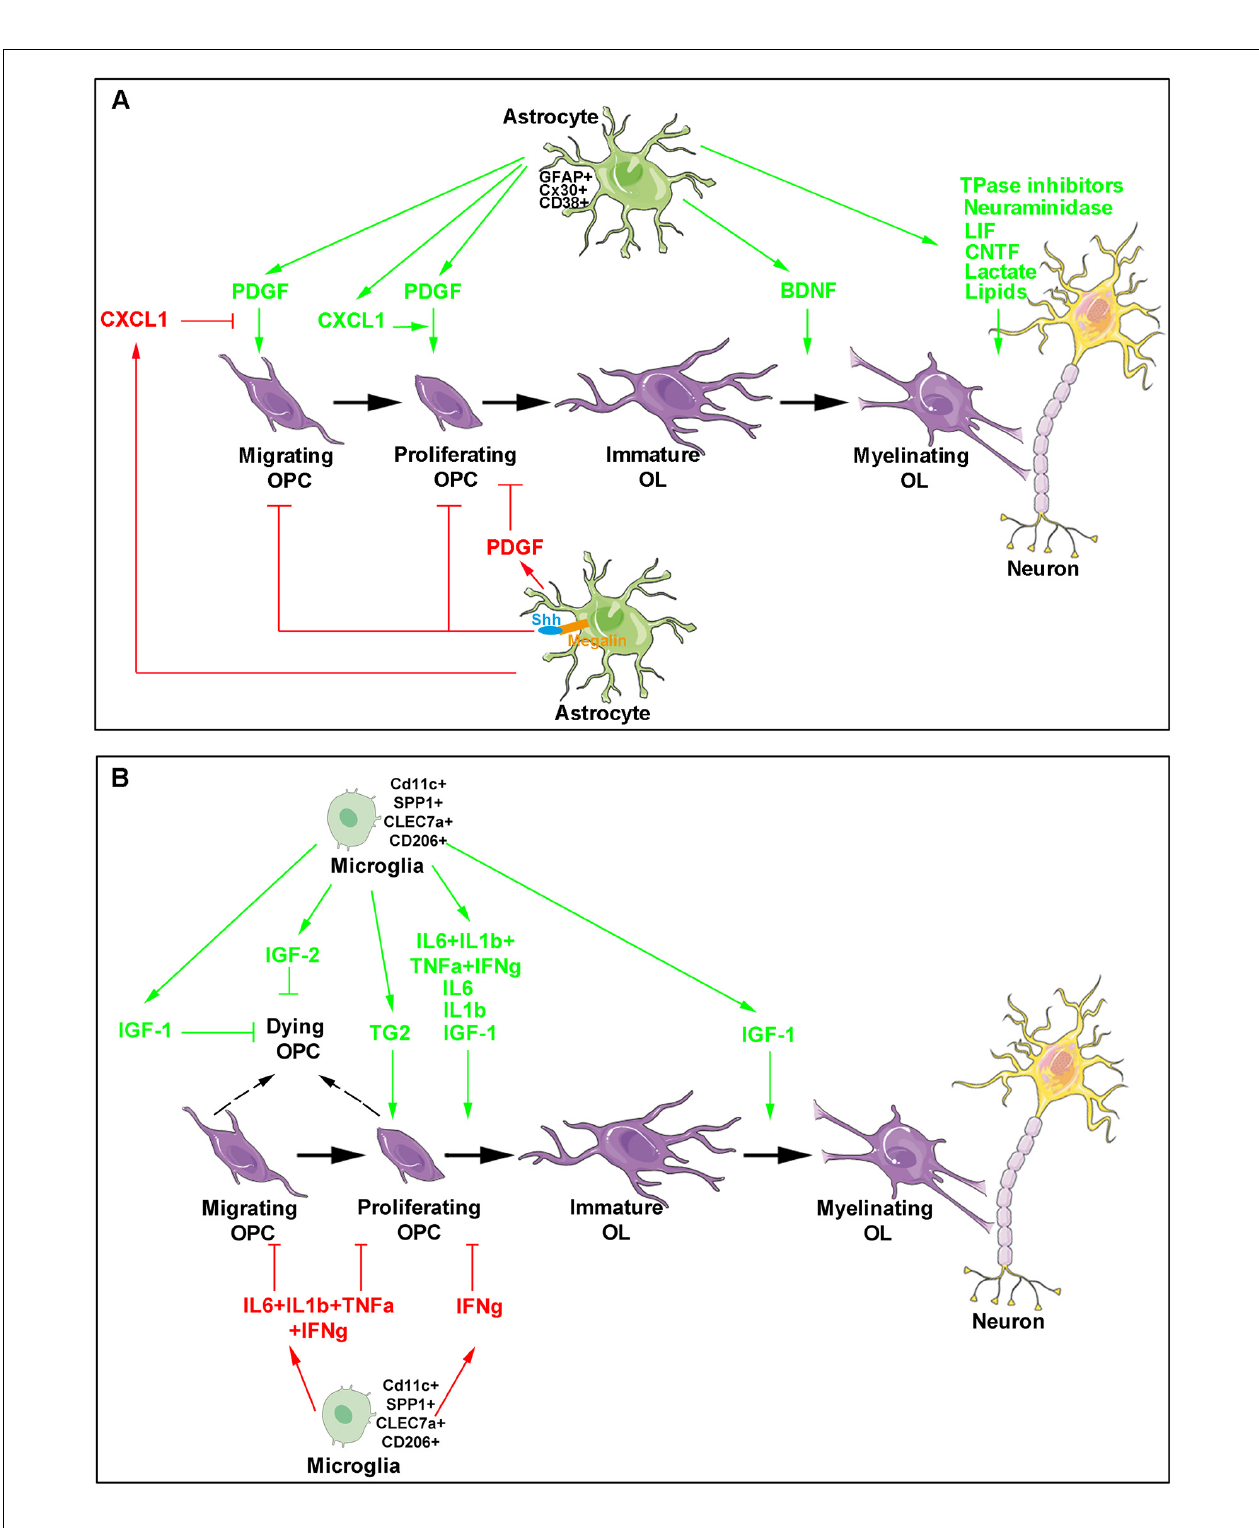
FIGURE 1 | Major roles of astrocytes and microglia during developmental oligodendrogenesis and myelination. The different steps of oligodendroglial cell production (purple) are shown and include oligodendrocyte progenitor cell (OPC) migration, proliferation, differentiation as well as the maturation of immature oligodendrocytes into cells able to myelinate neuronal axons. Astrocyte- (A) and microglia- (B) derived molecules are indicated. The green arrows indicate molecules exhibiting a positive activity on oligodendrocyte lineage and myelin production (top in each panel) whereas the red arrows and blocking symbols indicate molecules displaying an inhibiting activity on oligodendroglial lineage production (bottom in each panel).